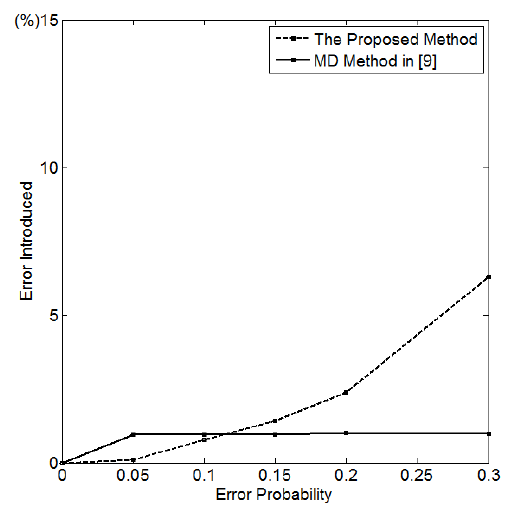
Figure 8. Comparison of With and Without Sliding Window On Probability of Errors